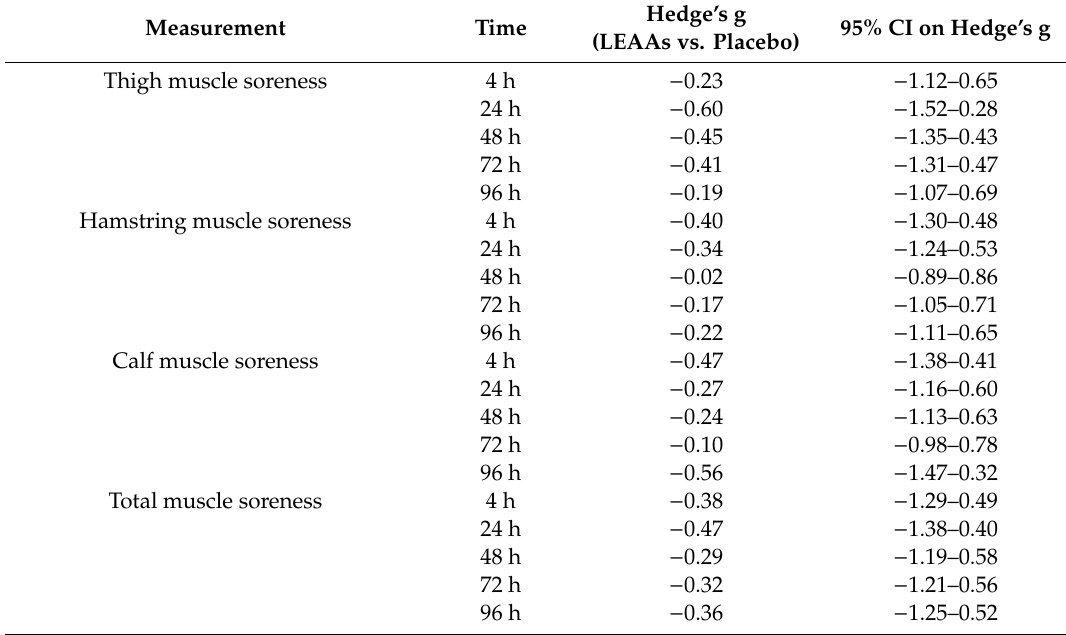
Table 3. E ff ect sizes and confidence intervals for thigh, hamstring, calf, and total perceived muscle soreness after resistance exercise in response to LEAA versus placebo consumption. Thresholds for small, moderate, and large e ff ect sizes are 0.2, 0.5, and 0.8